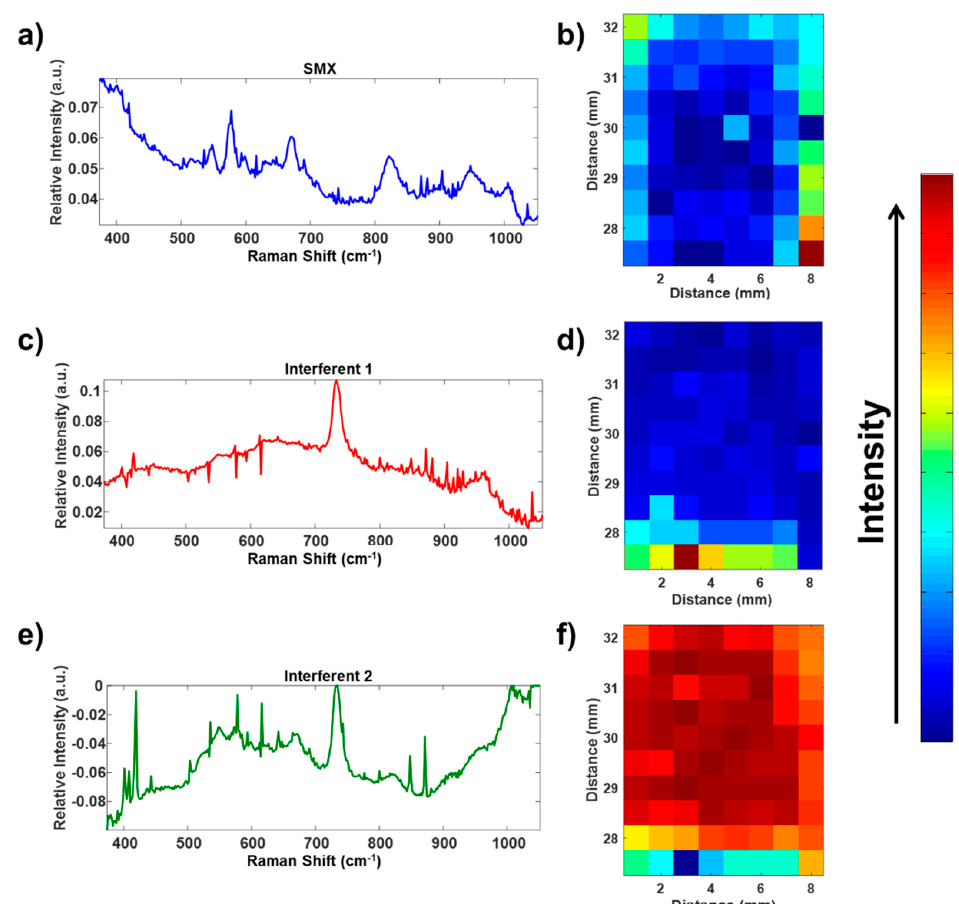
Figure 8. ( a ) Recovered SERS spectrum and ( b ) score map for SMX, ( c ) recovered SERS spectrum and ( d ) score map for interferent 1, and ( e ) recovered SERS spectrum and ( f ) score map for interferent 2 for milk sample spiked to 2 times the MRL concentration for SMX.